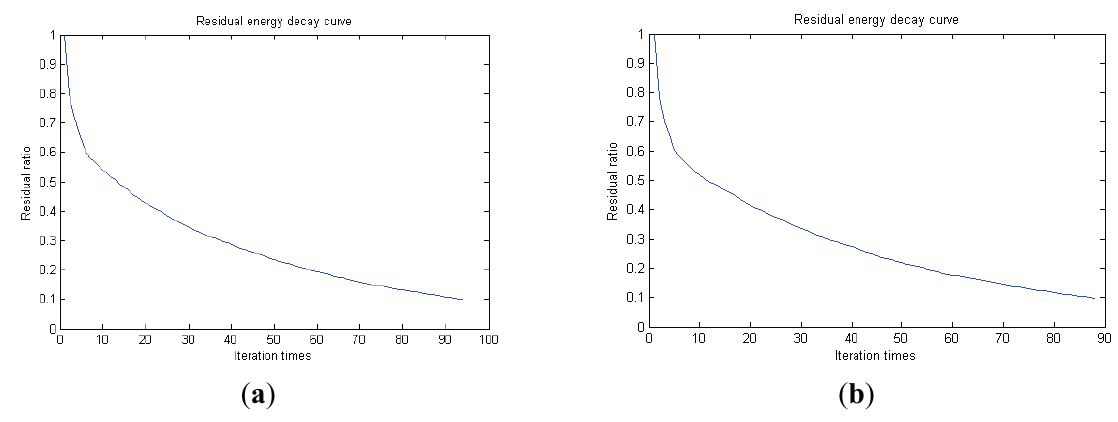
Figure 7. Residual energy decay curve: ( a ) first 512 points; ( b ) last 512